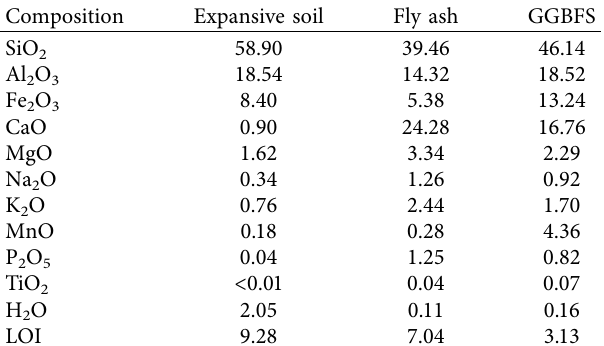
Table 1: Te chemical characterization of materials used. Composition Expansive